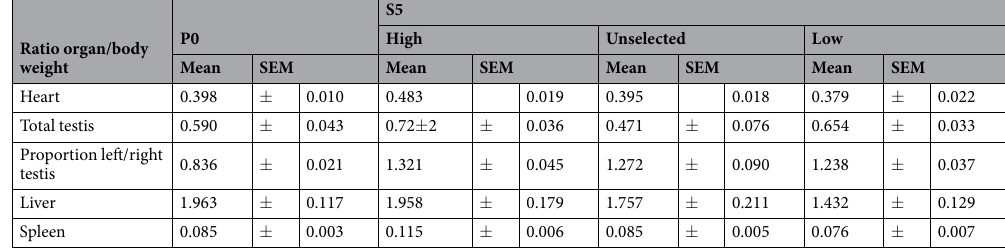
Table 1. Mean organ weight in percent of body weight ( + / − SEM) in the parental generation (P0) and the fifth generation (S5) selected for “High” or “Low” fear of humans, or